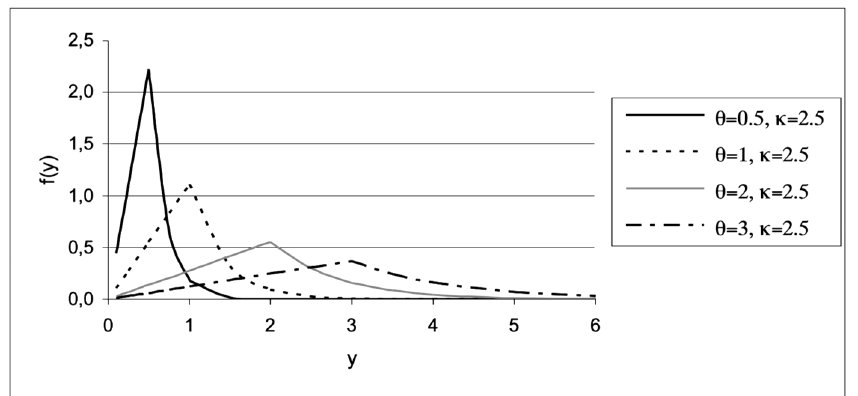
Figure 11 – Two-faced probability density function ( κ =2.5, θ ̣